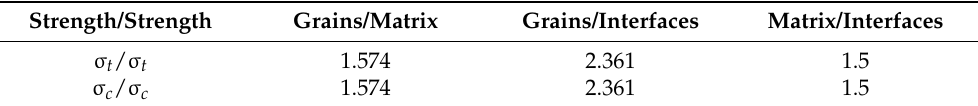
Table 3. Strength ratios.